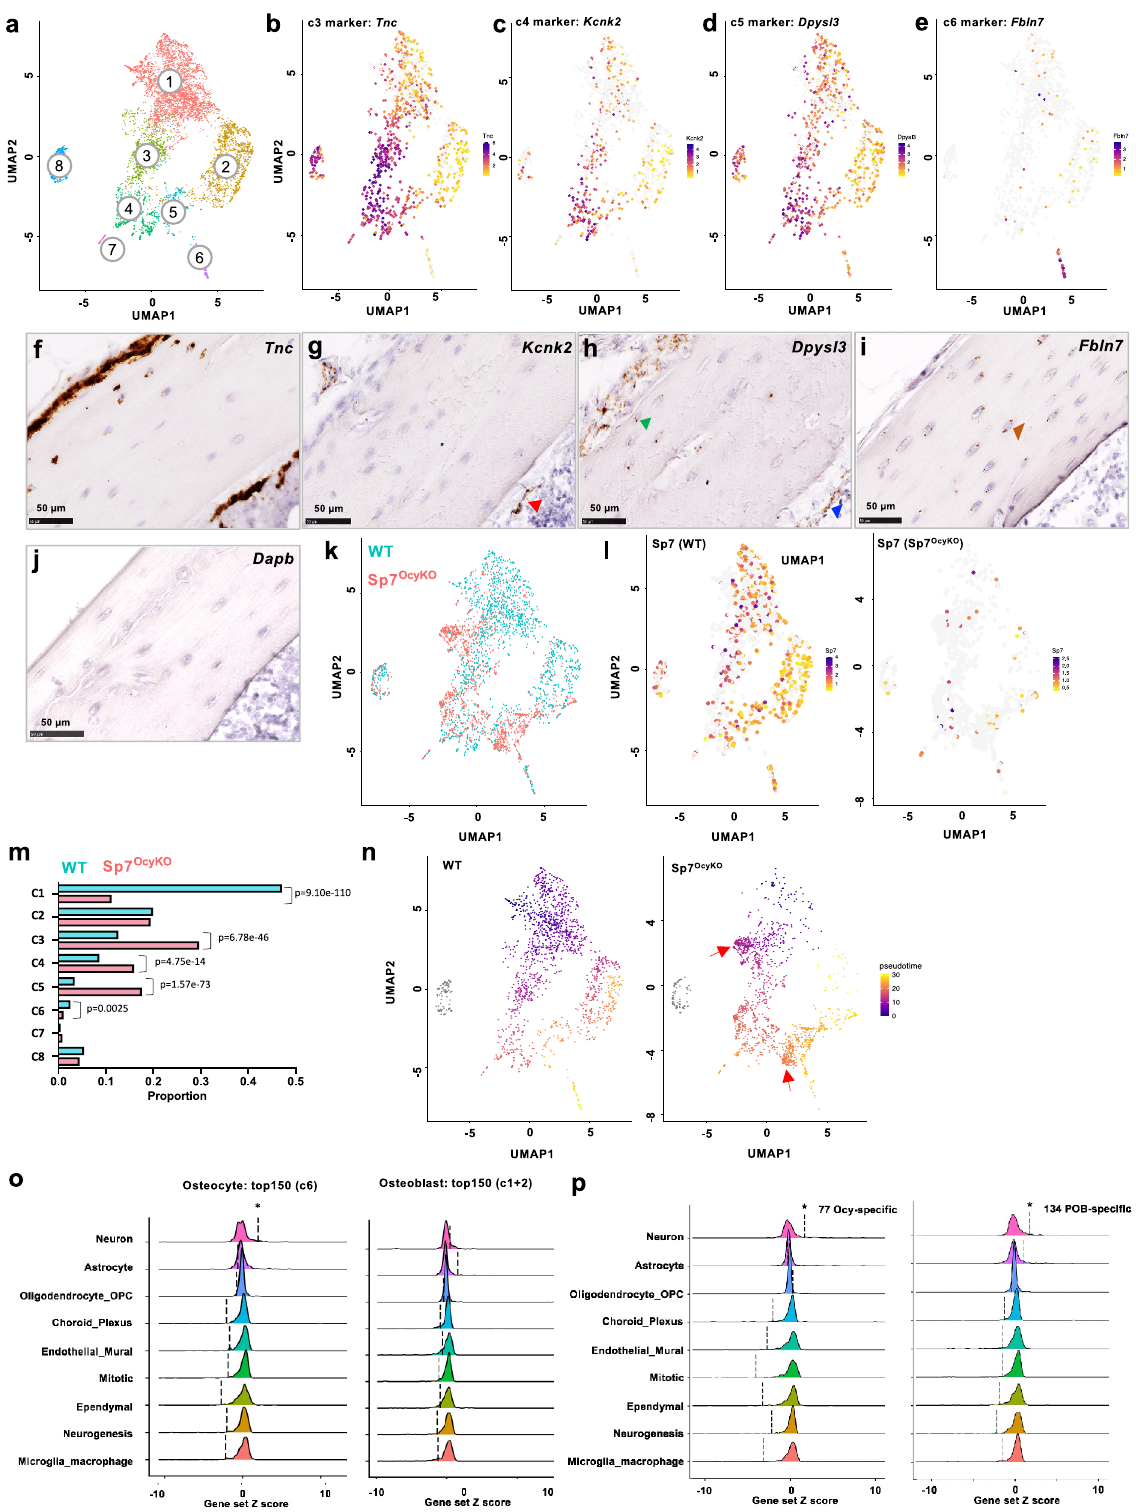
performed in 293T cells using standard protocols (http://www.broadinstitute.org/ rnai/public/resources/protocols). In brief, HEK293T cells were plated at 2.2 ×10 5 ml − 1 and transfected the following day with an shRNA-expressing plas- mid (shSp7 or shLacZ plasmid) along with psPAX2 (Addgene, plasmid 12260) and pMD2.G (Addgene, plasmid 12259) using Fugene-HD (Promega). The medium was changed the next day and collected 48h later. Ocy454 cells were exposed to lentiviral particles overnight at 33 °C in the presence of polybrene (2.5 µgml − 1